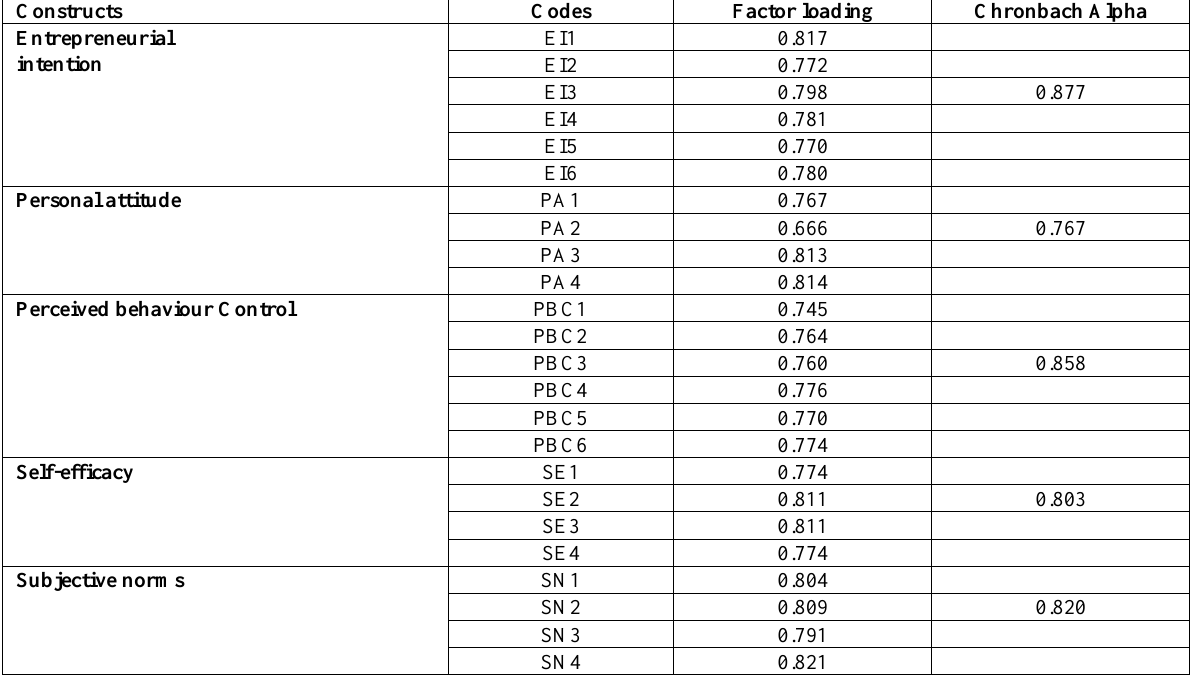
Table 2. Construct Reliability and